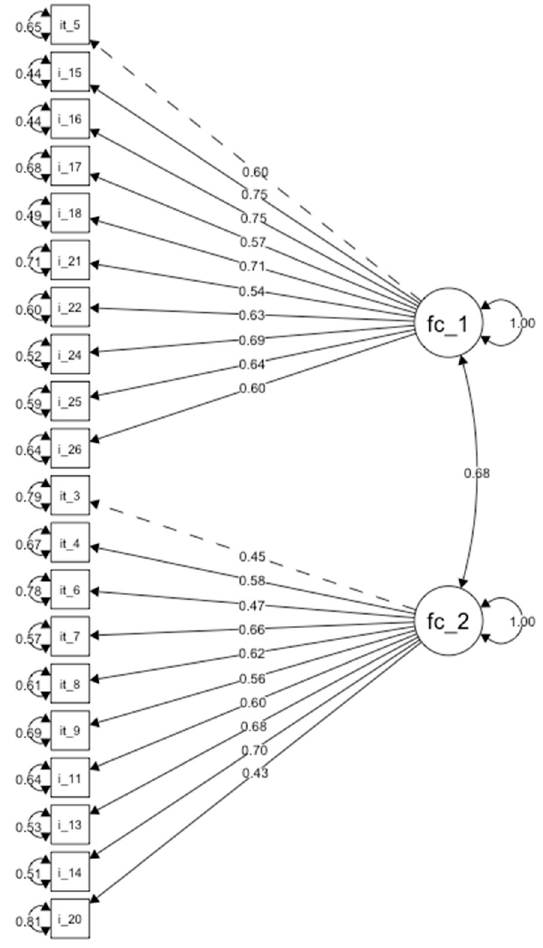
Figure 2. Confirmatory Factor Analysis path Figure 2. Con fi rmatory Factor Analysis path diagram.